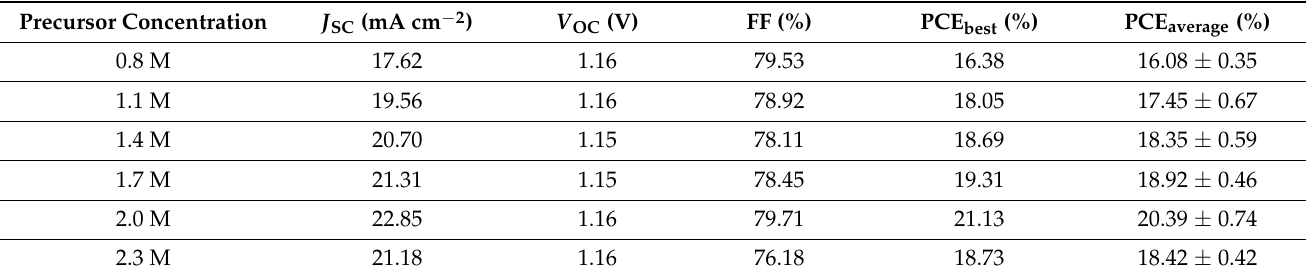
Table 1. Photovoltaic performance of PSCs fabricated at various precursor